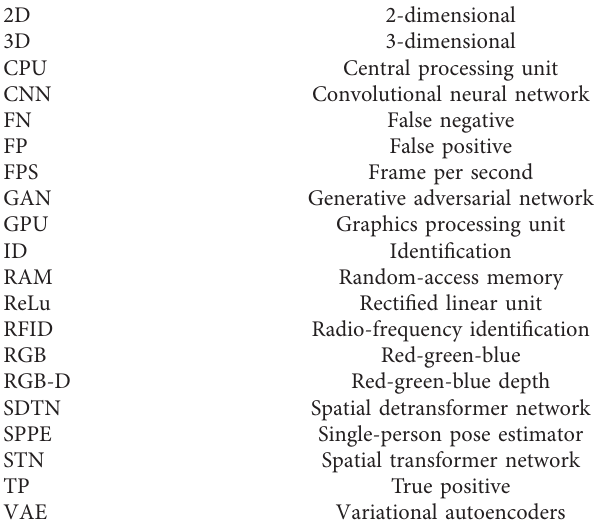
Table 1: The list of abbreviations used in this